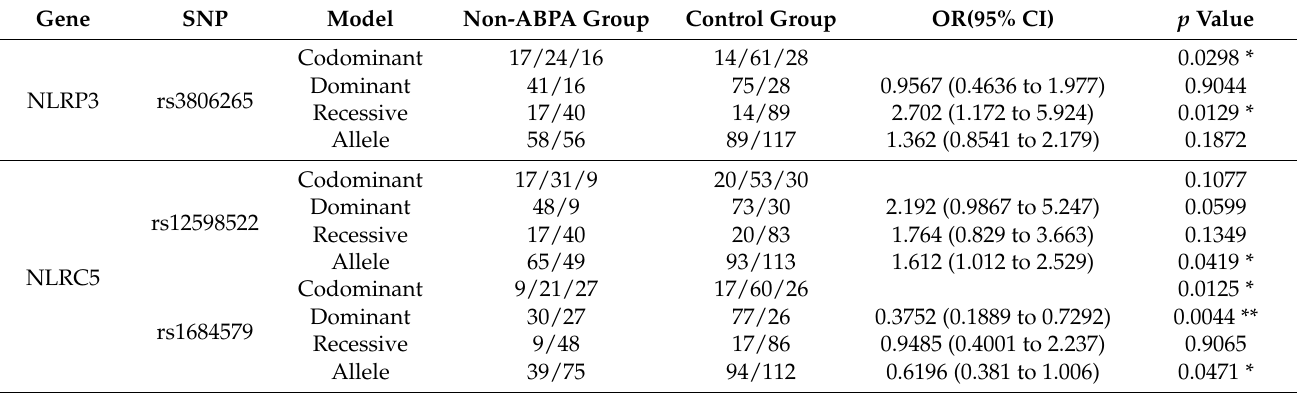
Table 4. Genotype distribution of NLRP3 rs3806265, NLRC5 rs1684579 and rs12598522 in non-ABPA group and